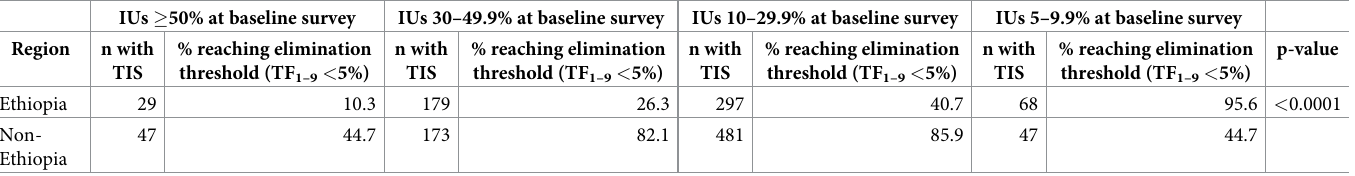
Table 2. Percent of IUs reaching the elimination threshold (TF 1–9 < 5%) by Ethiopia/non-Ethiopia and baseline category. IUs � 50% at baseline survey